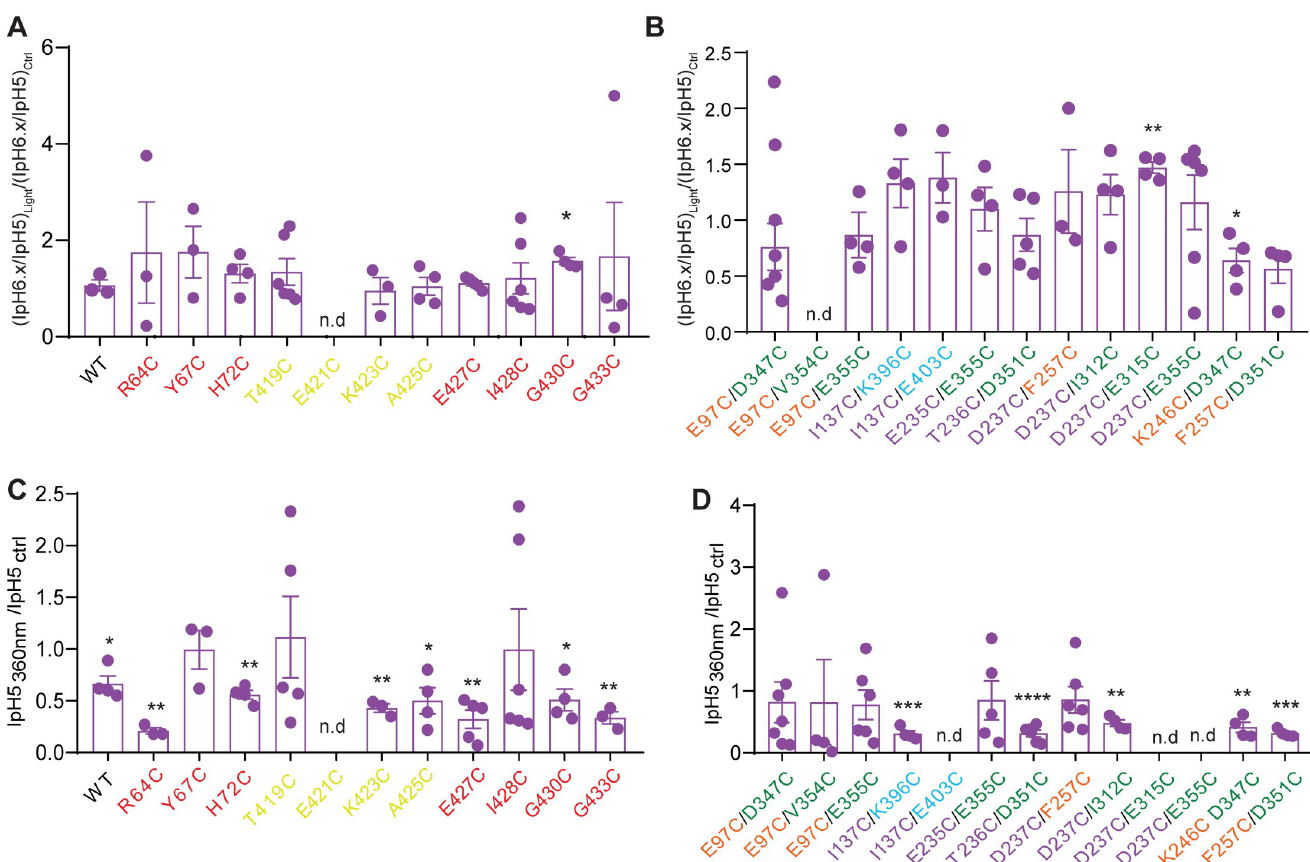
Fig 5. Modulatory effect of BMA and 360nm light. Data are from whole-cell patch-clamp recordings of transfected CHO cells, voltage-clamped to -60mV. A-B , (IpH6.x/IpH5) Light )/(IpH6.x/IpH5) Ctrl ratio in WT and mutants of the lower palm, TM1 and TM2 domain ( A ), and in double mutants of the extracellular domain ( B ). The pH6.x corresponded to 6.0 in D237C/I312C and F257C/D351C, pH5.5 in K246C/D347C, and pH6.4. in all other mutants. C-D , IpH5 Light /IpH5 Ctrl ratio, in WT and mutants of the lower palm, TM1 and TM2 domain ( C ), and in the double mutants of the extracellular domain ( D ). The 360nm light was pre-applied 200ms before and co-applied during the perfusion with the acidic solutions. Statistically significant differences between 360nm light and control condition are reported for IpH6.x/IpH5 and IpH5 as � , p < 0.05, �� , p < 0.01, ��� , p < 0.001, ���� , p < 0.0001 (paired t-test). The color of the mutant label matches that of the domain in which the mutation is located.